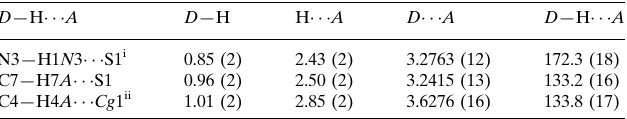
Hydrogen-bond geometry (A˚ , (cid:2)